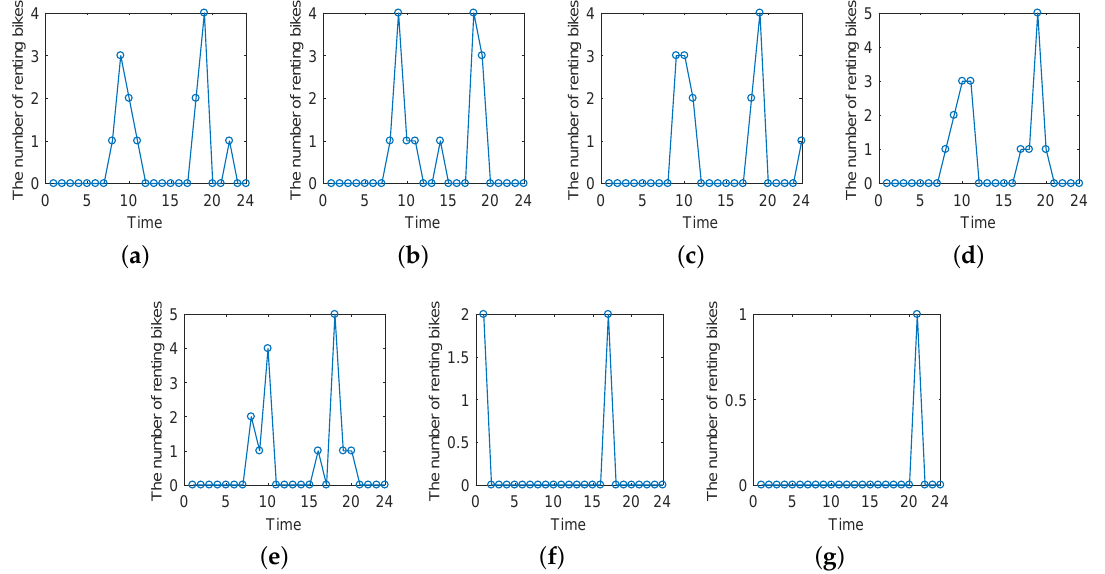
Figure 8. Bike usage on workdays and weekends. ( a ) Monday; ( b ) Tuesday; ( c ) Wednesday; ( d ) Thursday; ( e ) Friday; ( f ) Saturday; ( g )